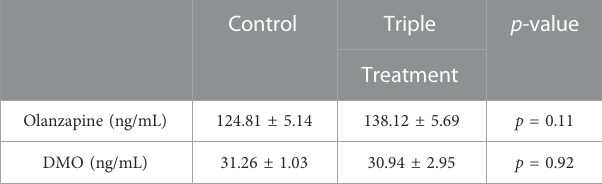
TABLE 1 Serum measures of olanzapine and N-desmethyl-olanzapine (DMO) taken 2 h following olanzapine or olanzapine plus triple treatment in